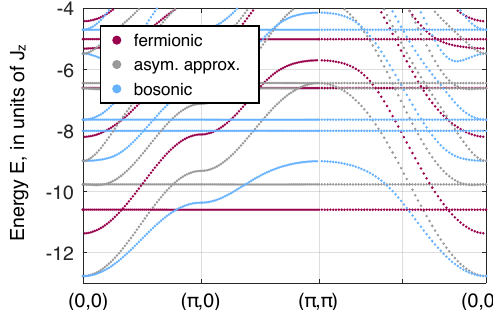
Figure 6: Two-hole eigenstates from the truncated string basis calculation. We com- pare fermionic (red) and bosonic (blue) holes, and show results from the asymmet- ric approximation (gray). The truncated basis used for the calculations includes all = 0,1,2 sectors, and string lengths up to ℓ = 0,..,3 and m ( 1 ) m 4 3 = 3 and a string potential for an Ising background. t/Jz=3, lmax=13, k=0.99 Pi sidered t / J t/Jz=3, lmax=13, k=0.01 Pi z